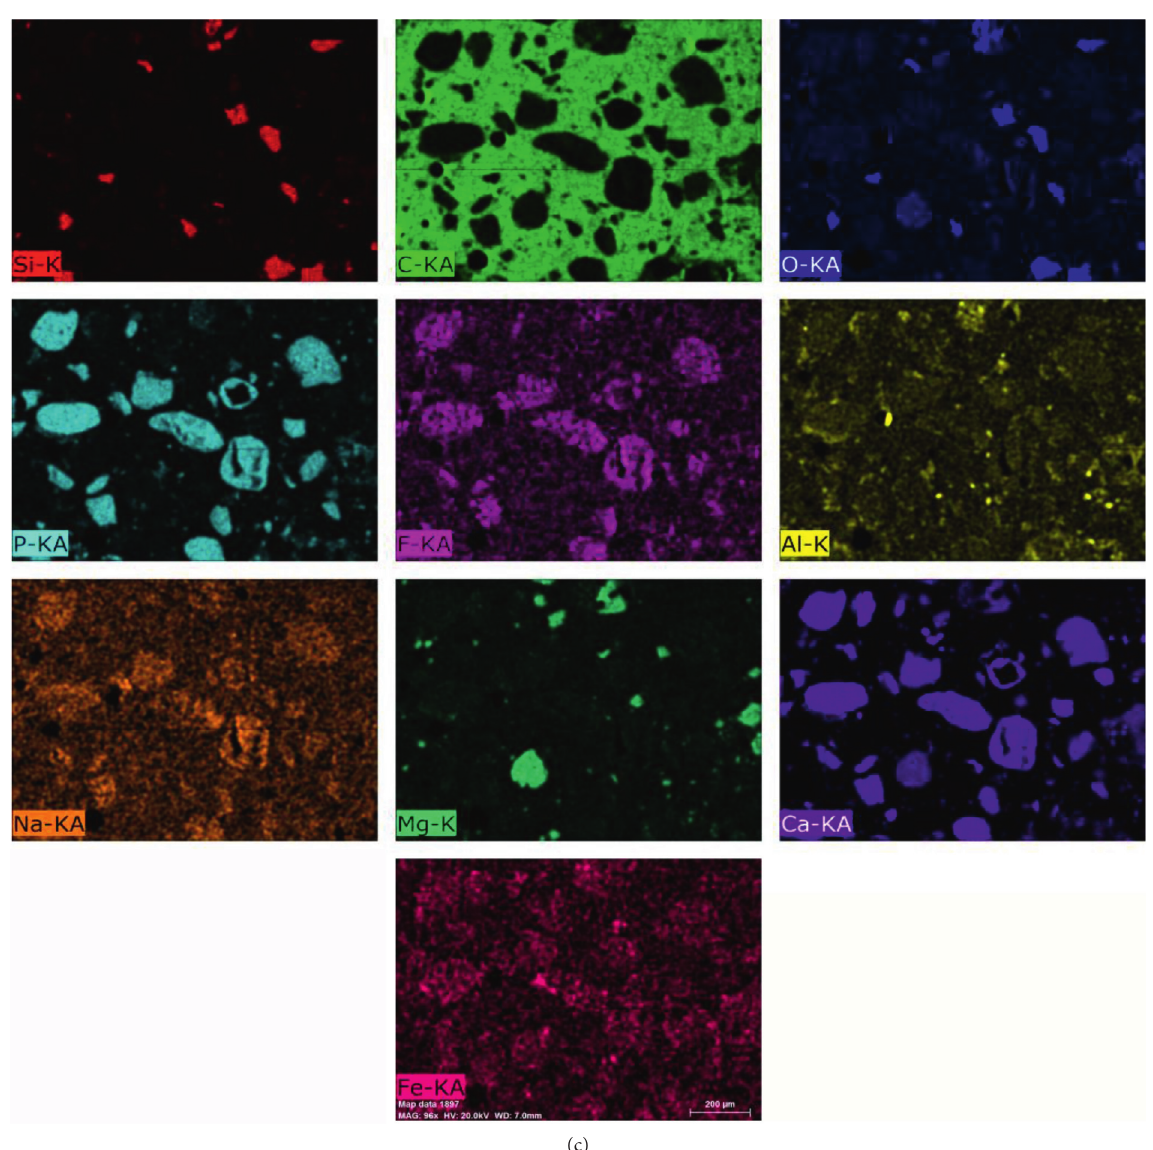
Figure 15: Backscattered electron diagram and element distribution diagram of collophane, quartz, dolomite, etc. (a) Backscattered electron image. (b) Backscattered element diagram. (c) Regional element distribution